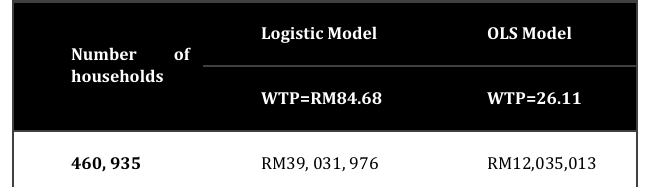
Table 3: Economic benefits of SMNR